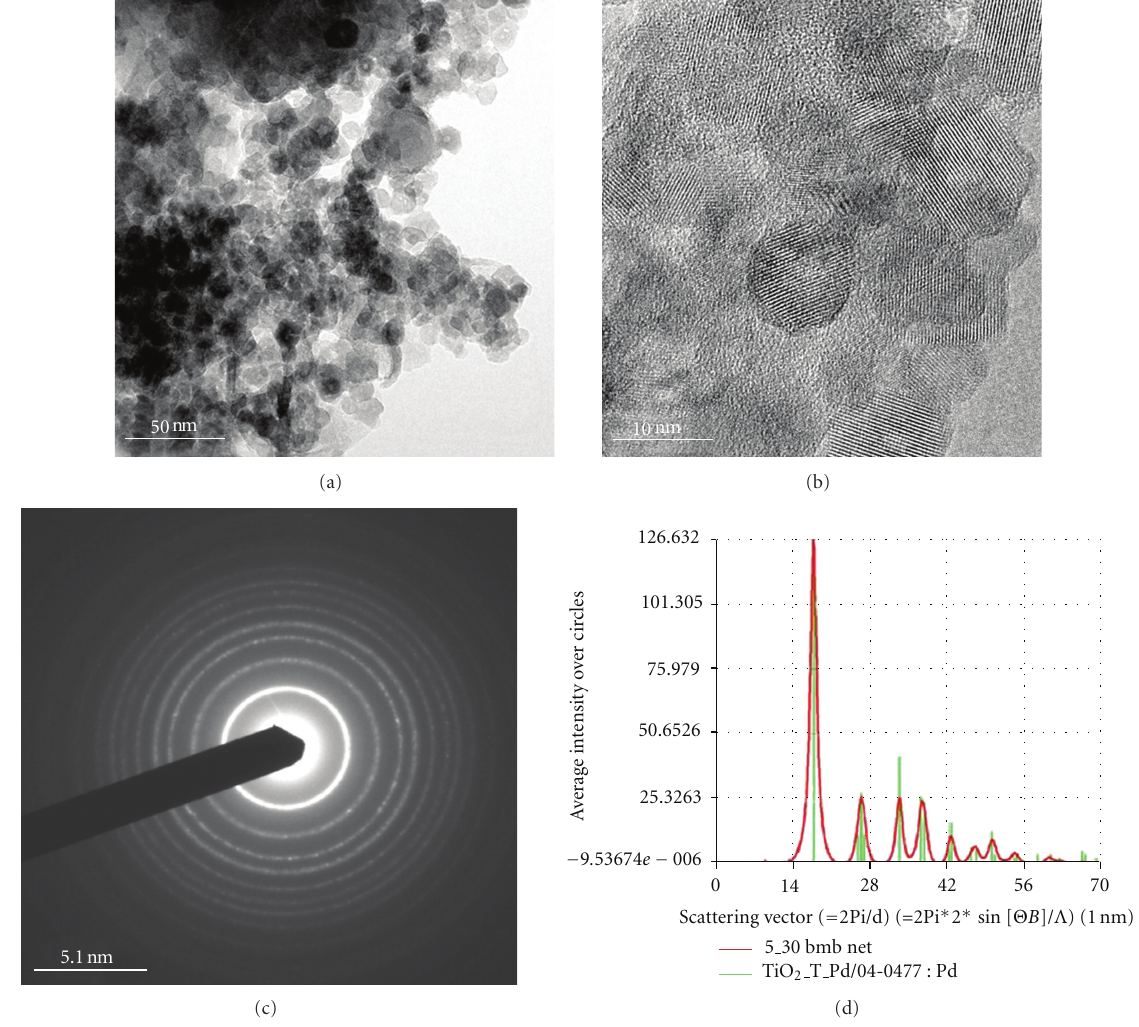
Figure 4: TEM micrographs (a, b) and electron di ff raction pattern (c, d) of the sample TIT 144